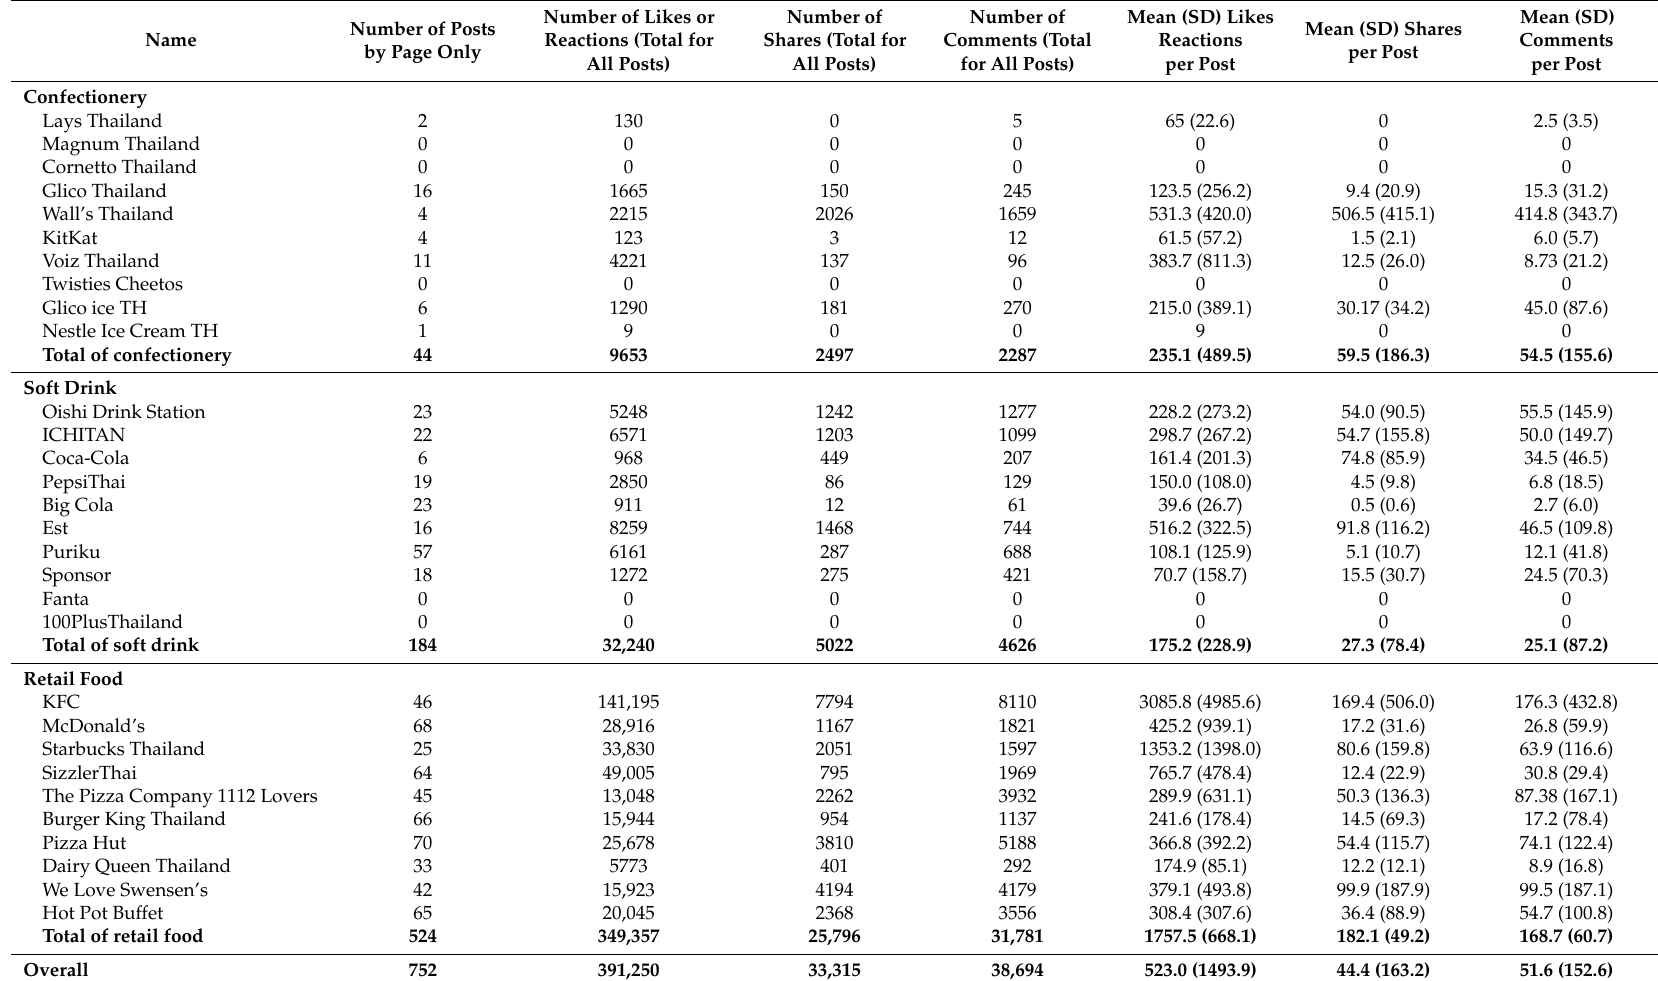
Table 2. Timeline posts by page of food Facebook pages 1–31 December